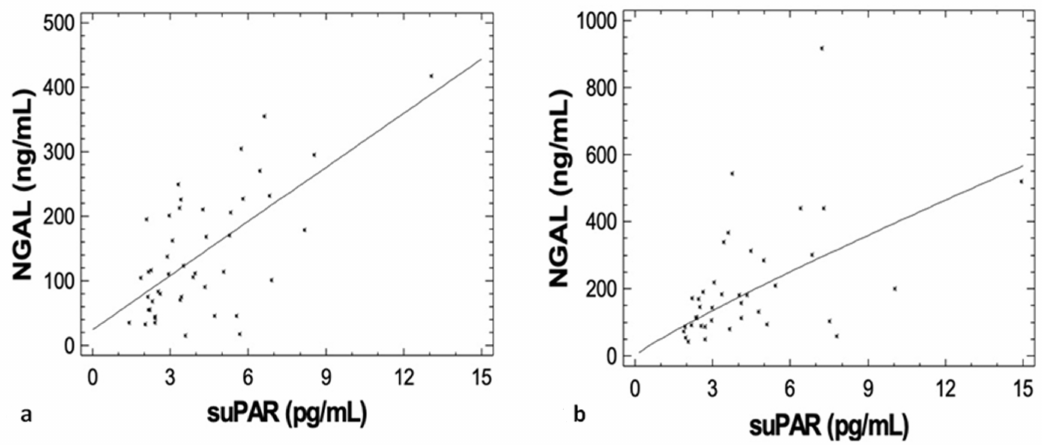
Figure 4. SuPAR levels were positively associated with Neutrophil Gelatinase-Associated Lipocalin (NGAL) values both ( a ) at diagnosis (r = 0.657, p < 0.001) and ( b ) at best response (r = 0.586, p <